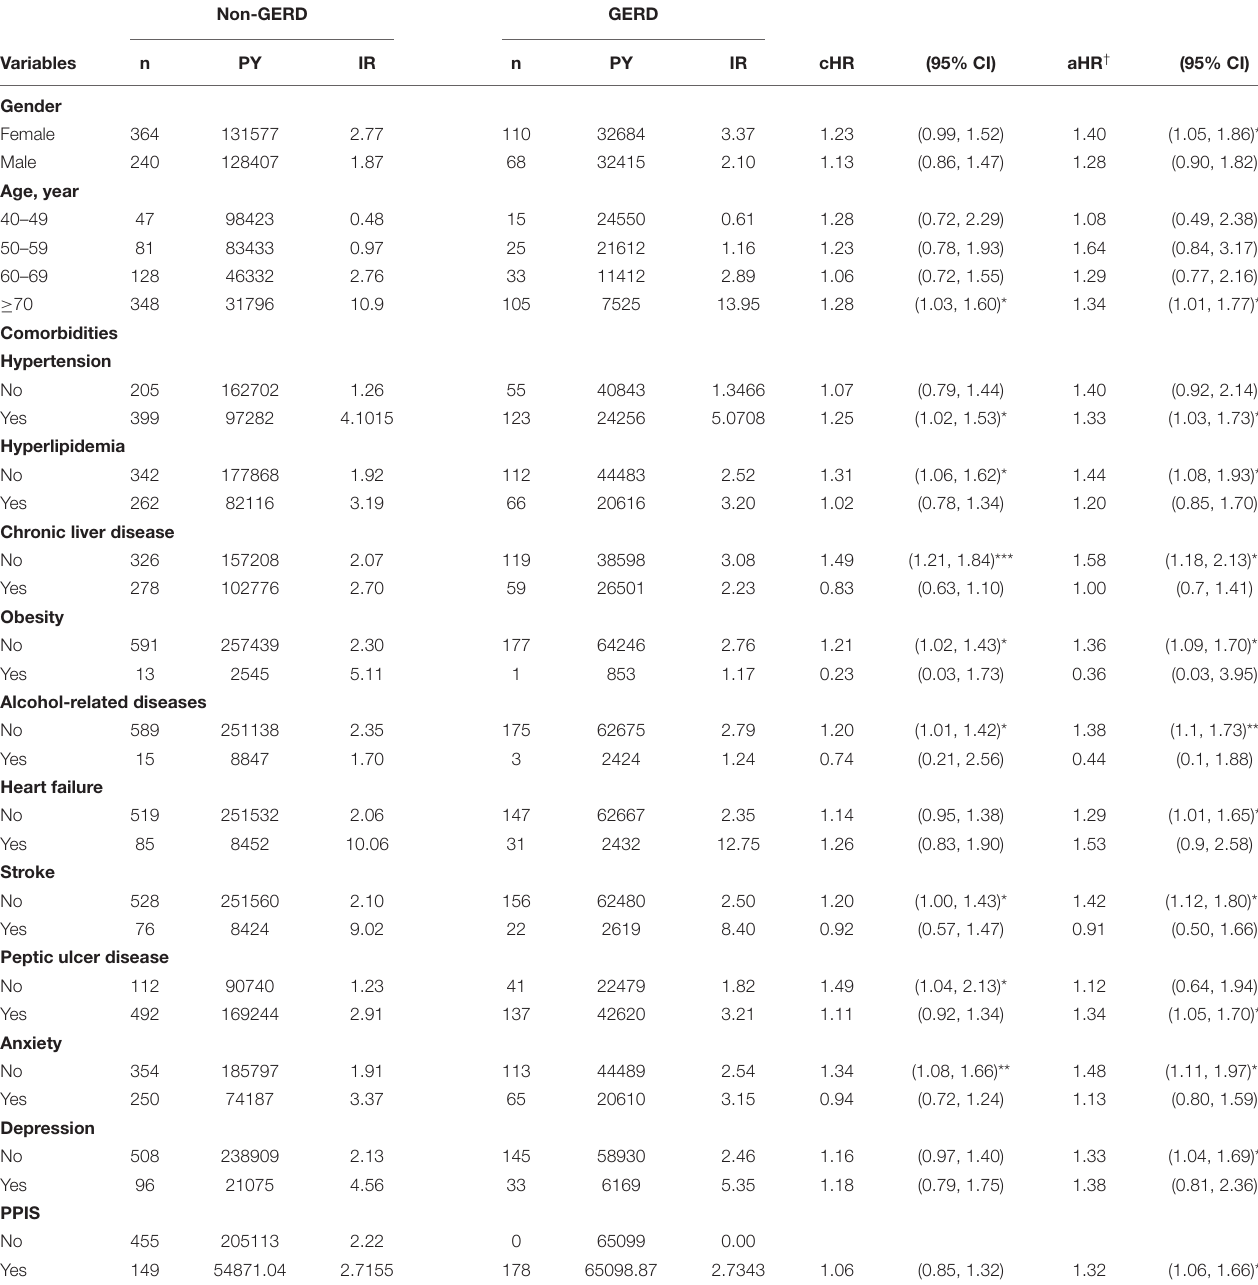
TABLE 3 | The risk of dementia in different stratification level. Non-GERD